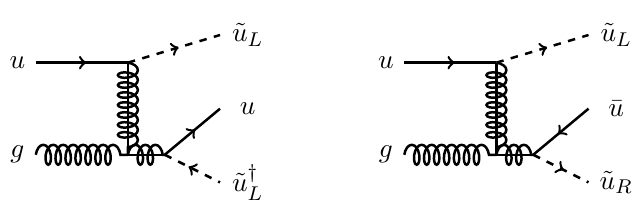
Figure 6. Example of real emission Feynman diagrams with s-channel gluinos for both (cid:12)nal states: gu ! ~ u L ~ u y u and gu ! ~ u L ~ u R (cid:22) u L